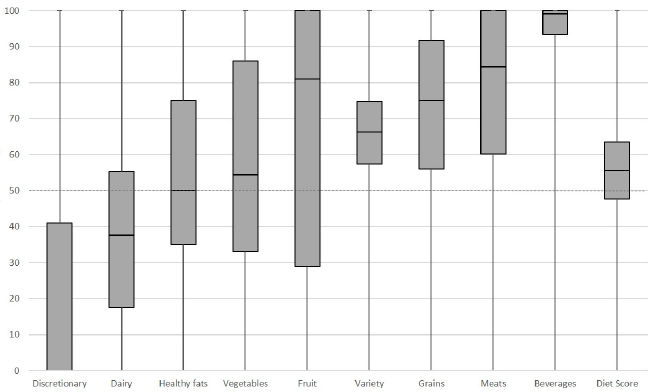
Figure 1. Box and whisker plot for the nine dietary guideline index components and total diet score ( n = 230,575). The dotted line marks the cut-off for a low score of less than 50 points of a possible 100.